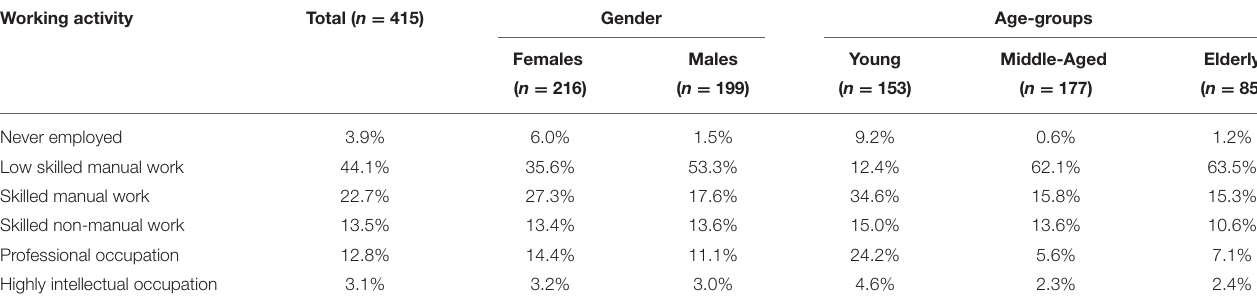
TABLE 2 | Frequencies of levels of working activity categories according to gender and age-groups. Working activity